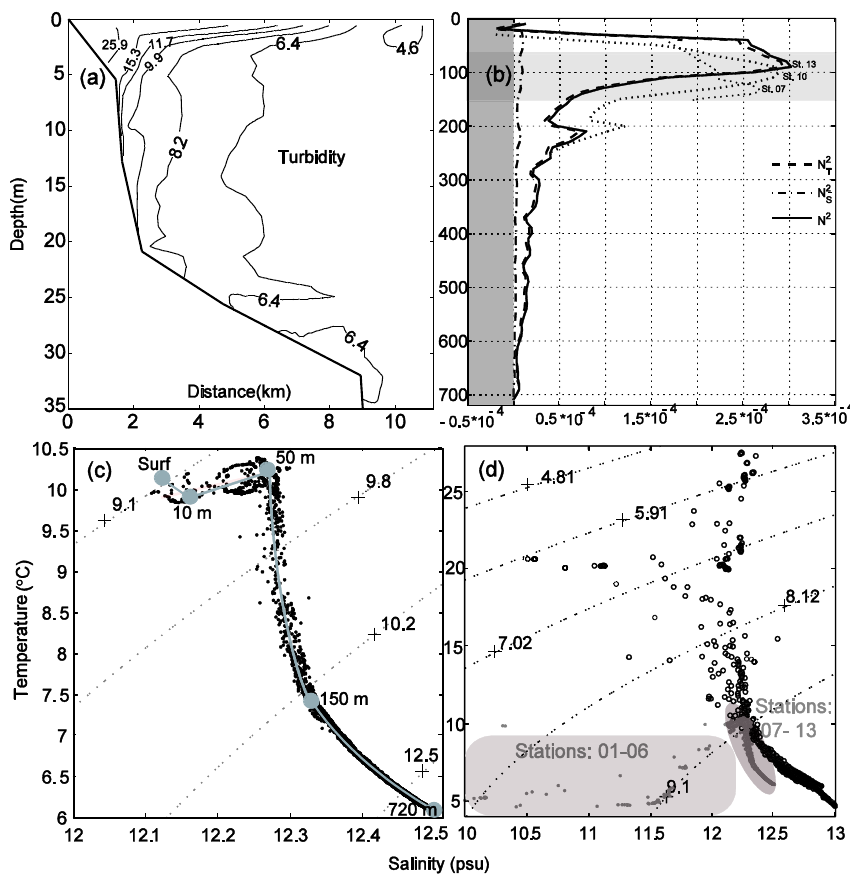
Fig. 3. Vertical Turbidity structure over the continental shelf, representing the high turbid inflow of AL. The turbidity unit is considered as NTU (a) , Brunt V¨ais¨al¨a frequency N 2 , which is a measure of the local stability of the water column, at the deepest station (solid line) and two shallower stations (dotted line) in the study area. N 2 is the sum of the contribution to stability by the temperature gradient N 2 salinity gradient N 2 (b) , T-S diagrams for outside the continental shelf (stations No. 07-13) in the southern western part of the CS in early S winter 2008 (c) , T-S plot of stations 01 to 03 of IAEA cruise 1996 which located in the south CS, in comparison with present study data (d)